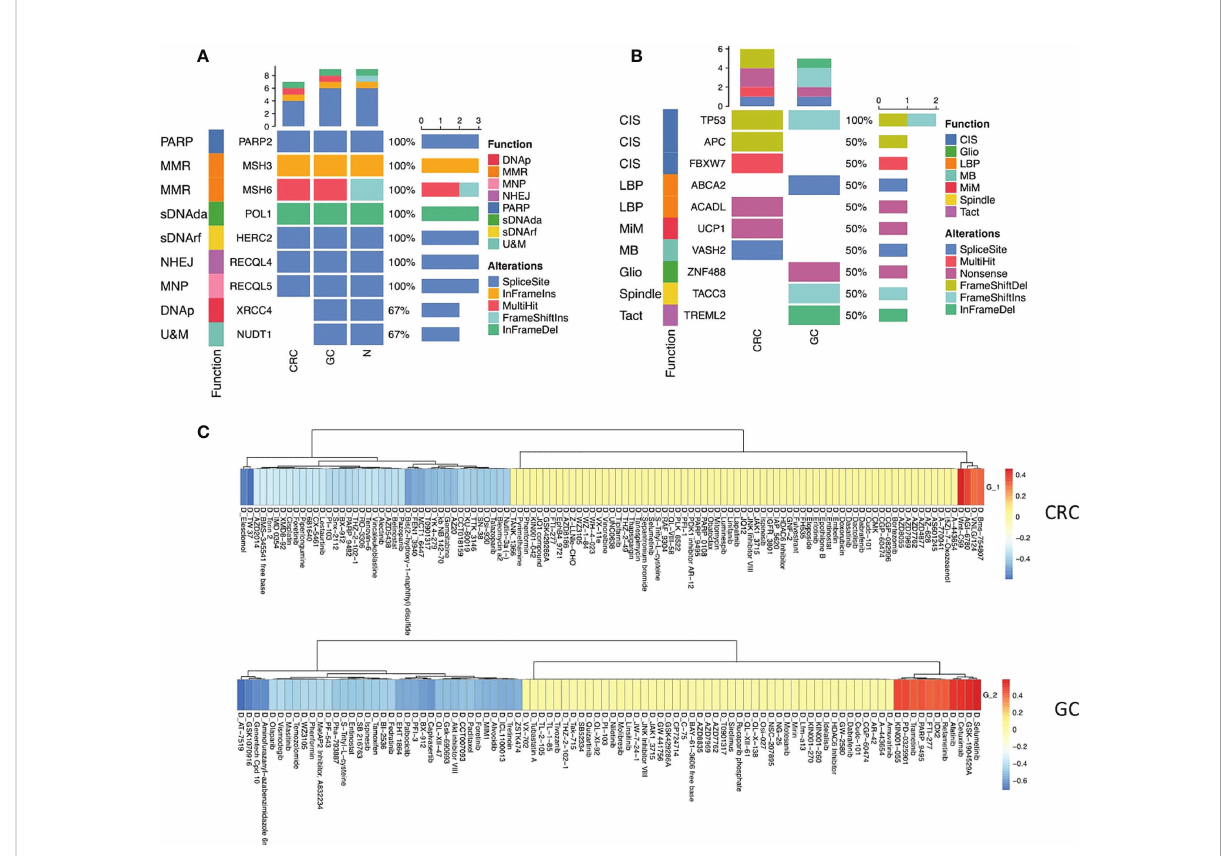
FIGURE 5 Mutational pro fi les of GC and CRC. (A) Oncoplot shows the germline mutations in CRC, GC, and normal sites. The top bar shows the counts of alterations type in each sample. The left annotation indicated the functions of the genes. The right bar shows the counts of alteration type of each gene. (B) Oncoplot shows the somatic mutations in CRC and GC sites. The top bar shows the counts of alteration type in each sample. The left annotation indicates the functions of the genes. The right bar shows the counts of alteration type of each gene. (C) Heatmaps show the correlation relationship between the subset GSVA score and the drug sensitivity for CRC and GC, respectively, collected from the GDSC database (top panel: CRC, bottom panel: